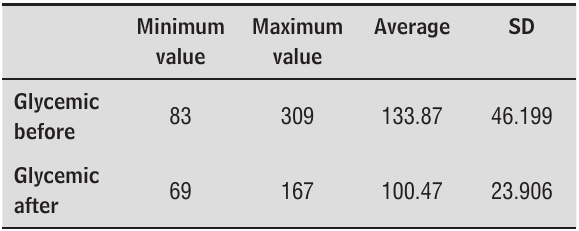
Table 3 - Glycemic index of ESF users before and after an intervention program in SUS, Iguaí, 2010 (n =